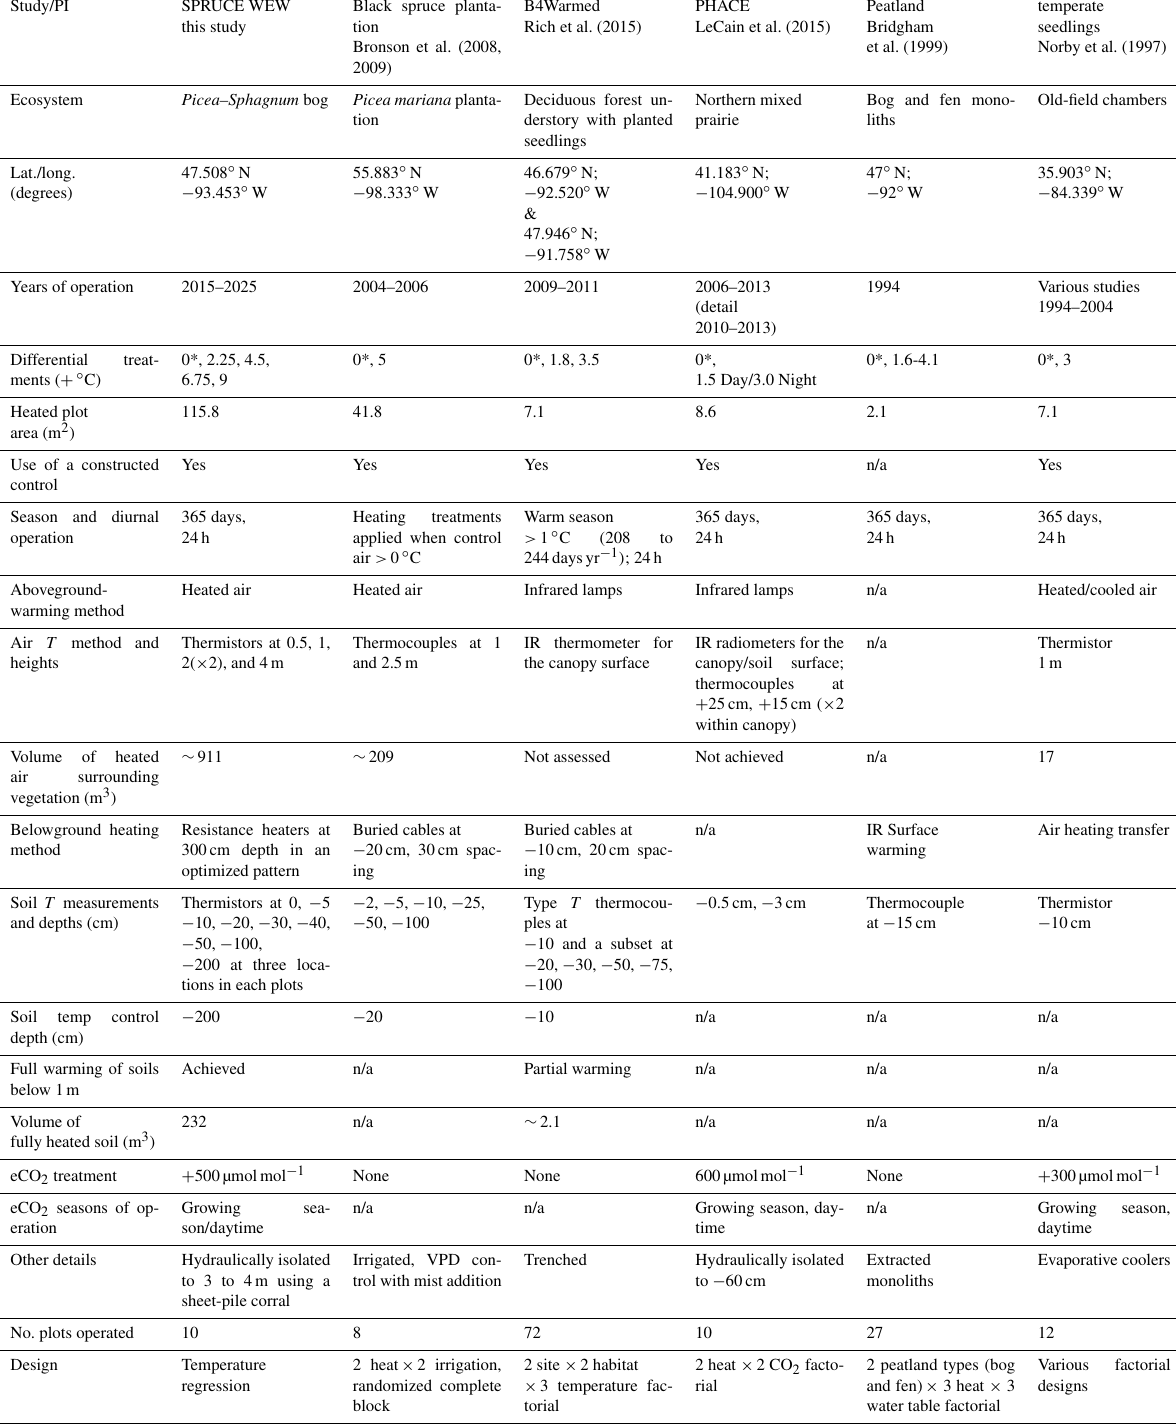
Table 6. Comparison of the SPRUCE WEW system characteristics to other representative plot-scale-warming approaches operated in field settings. Data are summarized at the individual plot level. Other warming studies not covered in this table are summarized by Rich et al. (2015), Aronson and McNulty (2009), LeCain et al. (2015) and Rustad et al. (2001).